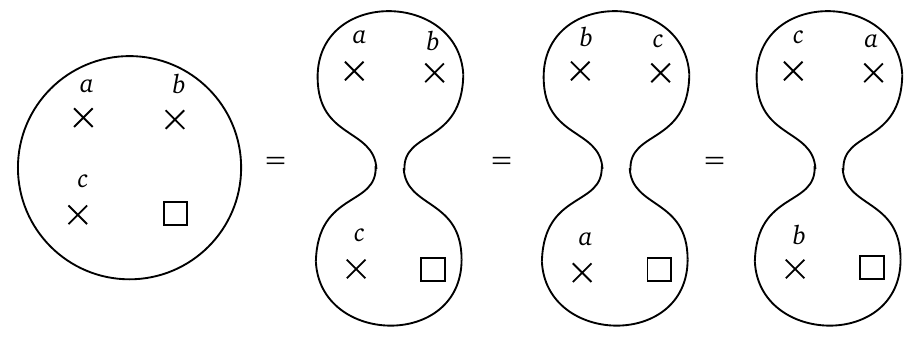
Figure 2: Three Duality frames of theory 55.